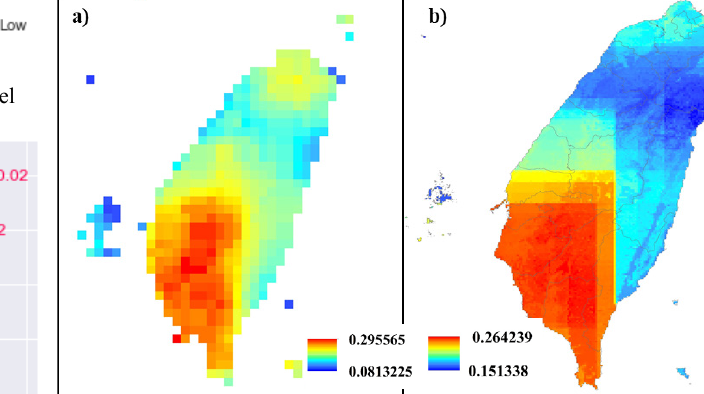
Fig.7 Annual mean original IMERG precipitation product (a), downscaled annual mean IMERG precipitation (b).